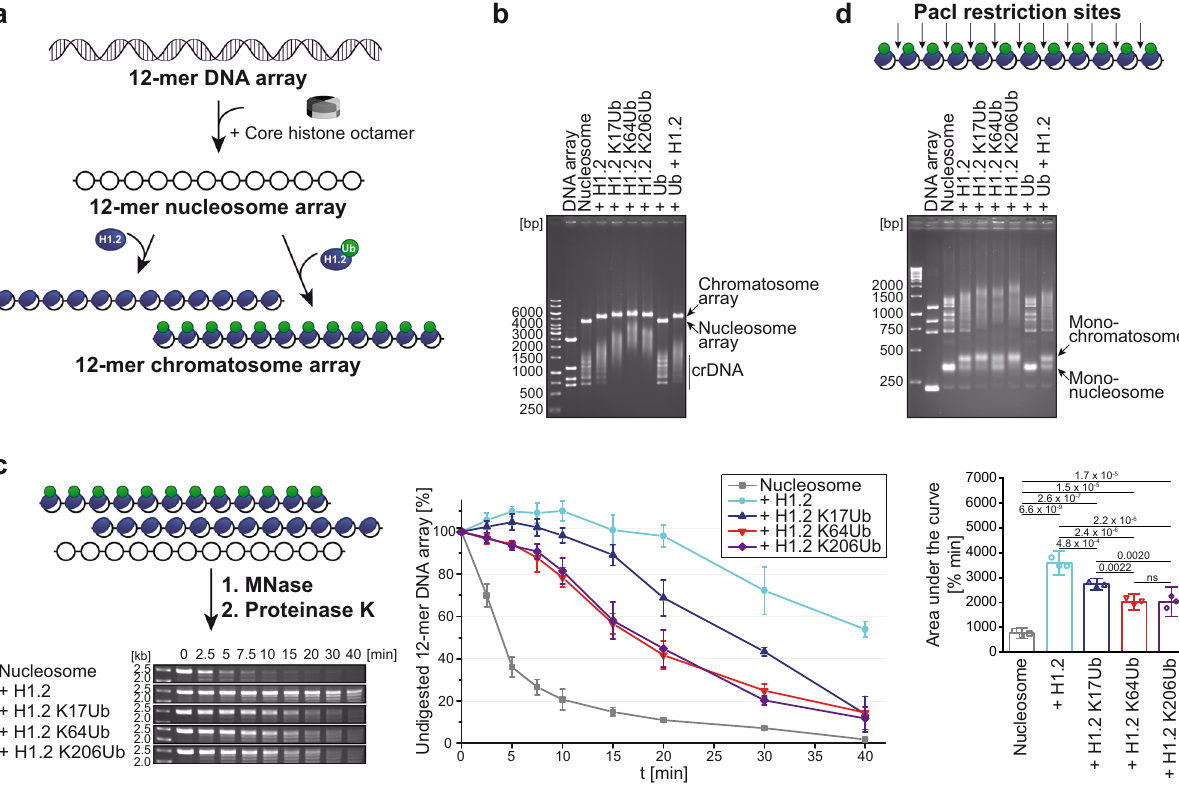
Fig. 4 Impact of H1.2 KxUb variants on chromatosome assembly. a Schematic overview of 12-mer chromatosome array formation containing H1.2 or H1.2 KxUbs. b EMSA of different arrays analyzed; crDNA indicates competitor DNA. c Overview of MNase digestion assay which probes DNA accessibility of nucleosome and chromatosome arrays (left). The arrays were treated with MNase for indicated times, digested by proteinase K, and analyzed by agarose gel electrophoresis. Undigested arrays were quanti fi ed and plotted over time (middle). Shown are mean values + / − standard deviation, n = 3. For statistical analysis, the area under the curve for the digestion of the different arrays was determined and analyzed (right); shown are mean values + / − standard deviation, n = 3, one-way ANOVA with Tukey ’ s multiple comparisons test with α = 0.05, 95% con fi dence interval, exact p values with p ≤ 0.05 are shown, ns (not signi fi cant) p > 0.05. d PacI digestion assay. PacI cleaves the array site-speci fi cally within the linker DNA between the repetitive nucleosome positioning sequences resulting in the formation of mono-nucleosomes and